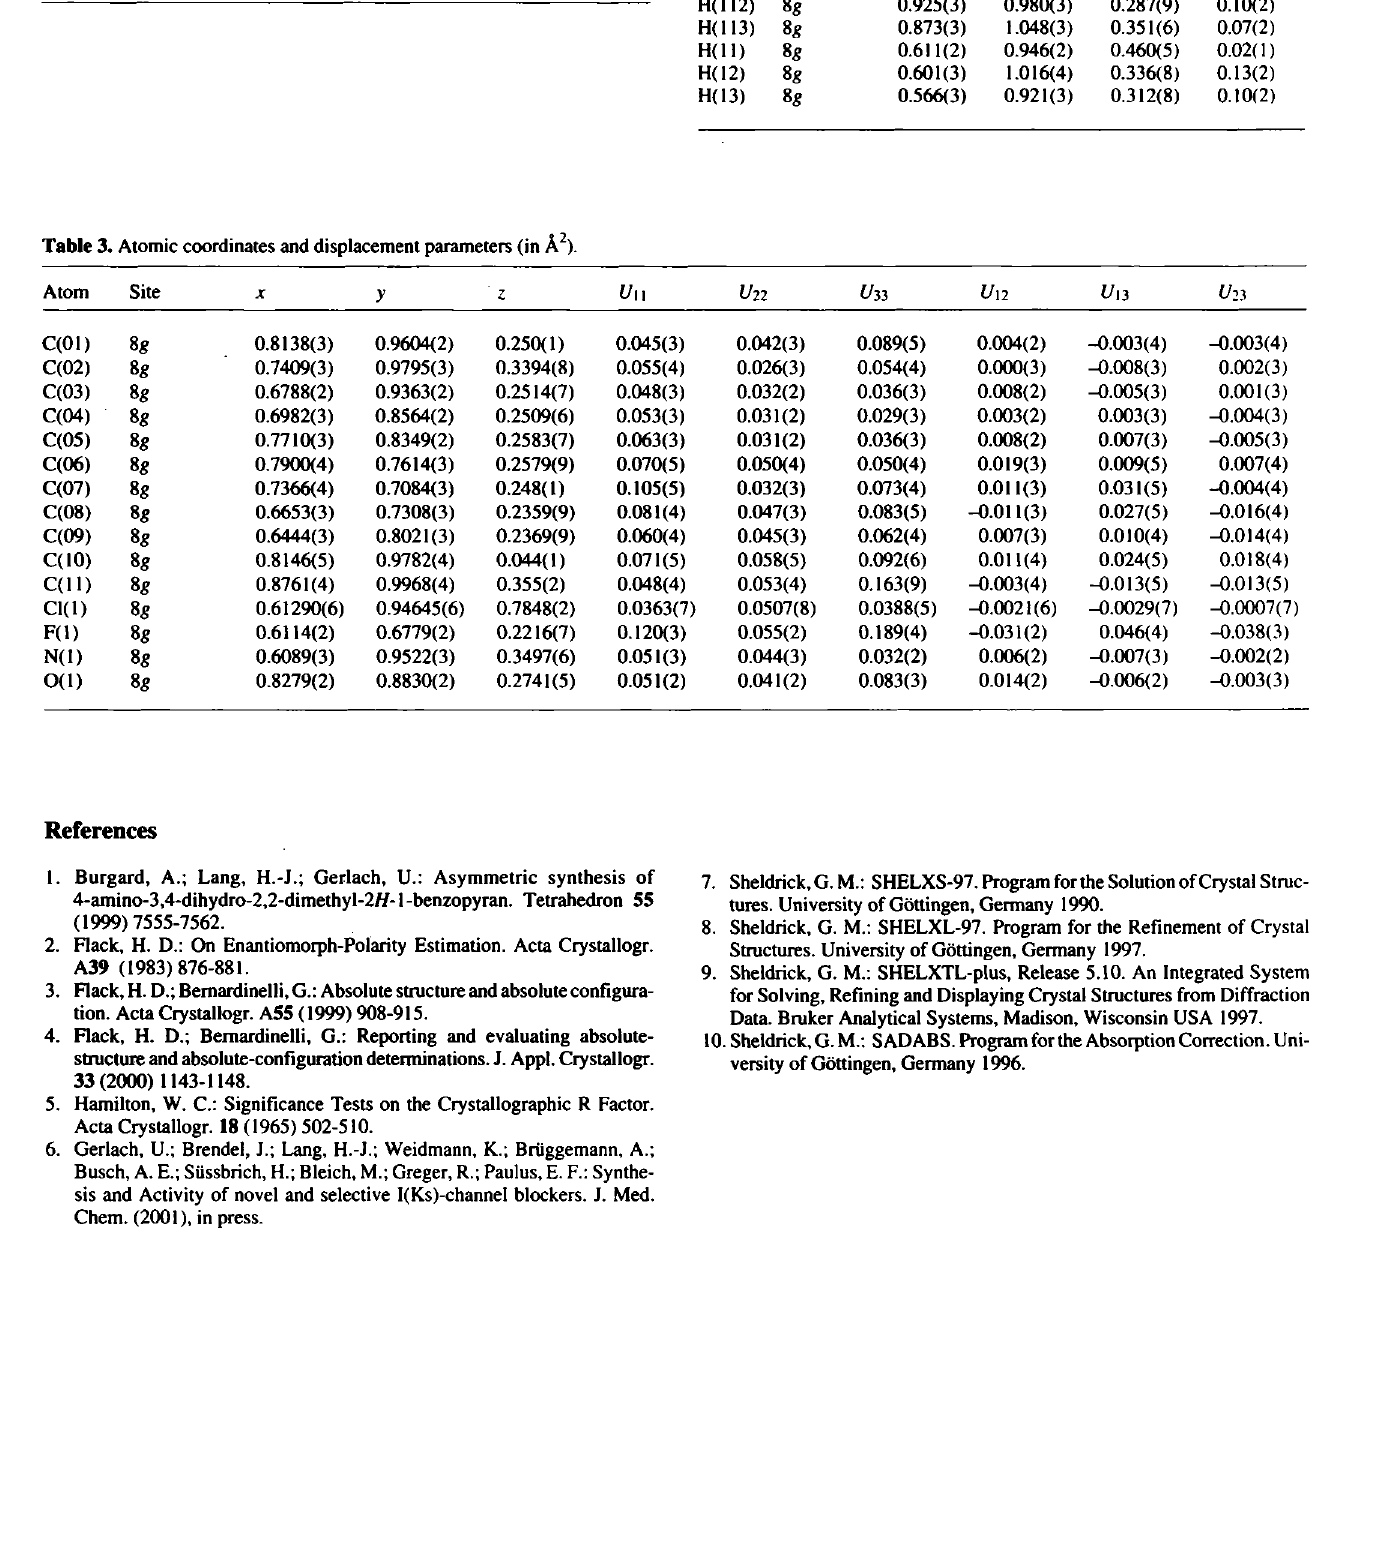
Table 3. Atomic coordinates and displacement parameters (in A 2